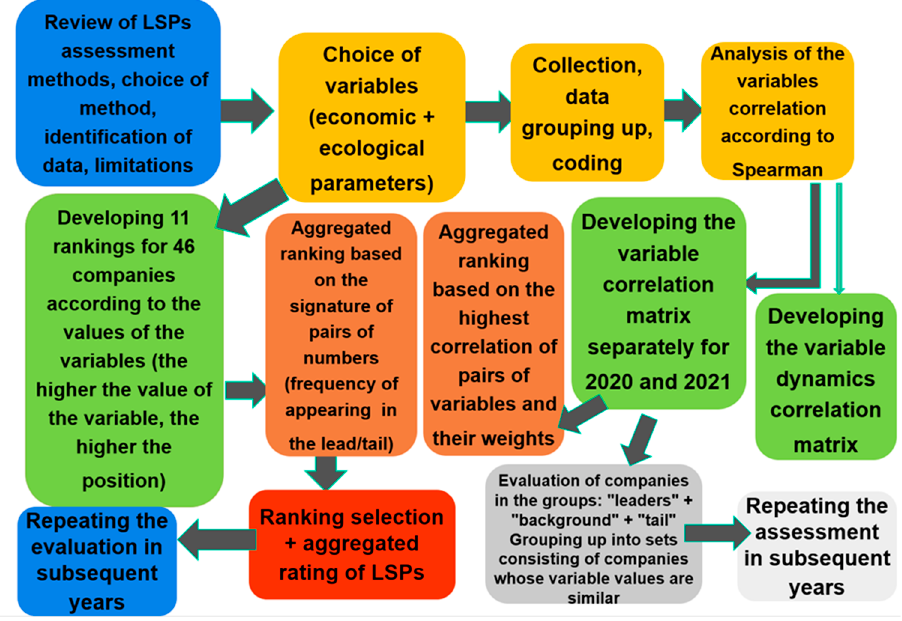
Figure 6. The scheme for conducting the LSP research together with the choice of the method.